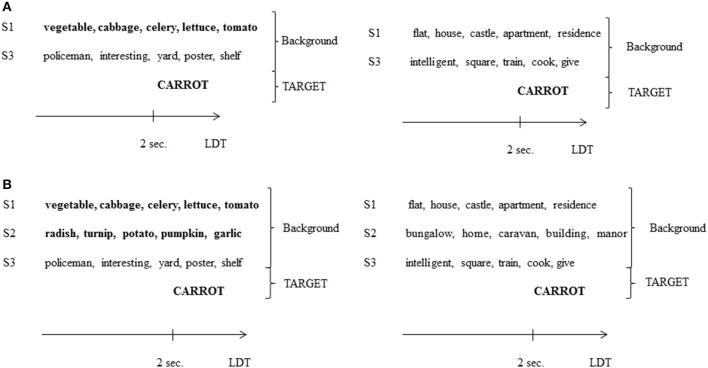
(A) Example of a background in the 1SC/1SI condition of Experiment 2, presented with a semantically related target word (left; related condition) or not (right; unrelated condition). S3, speaker 3 (see the legend of Figure 1 for other abbreviations). (B) Example of a background in the 2SC/1SI condition of Experiment 2, presented with a semantically related target word (left; related condition) or not (right; unrelated condition).